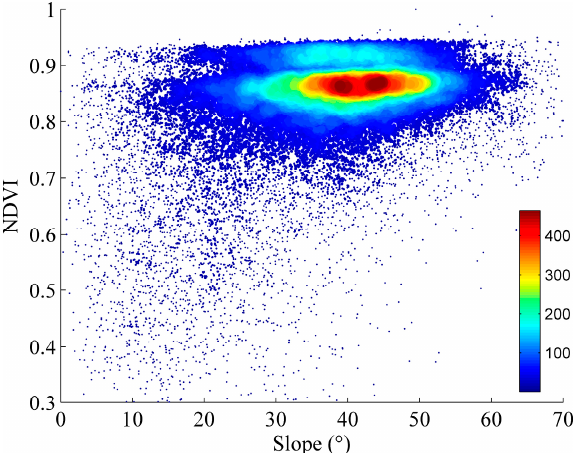
Figure 8. Density scatterplot between slope and NDVI in our study area. NDVI shows near- Density scatterplot between slope and NDVI in our study area. NDVI shows independence with slope with a Pearson correlation coefficient equal to 0.14. near-independence with slope with a Pearson correlation coefficient equal to